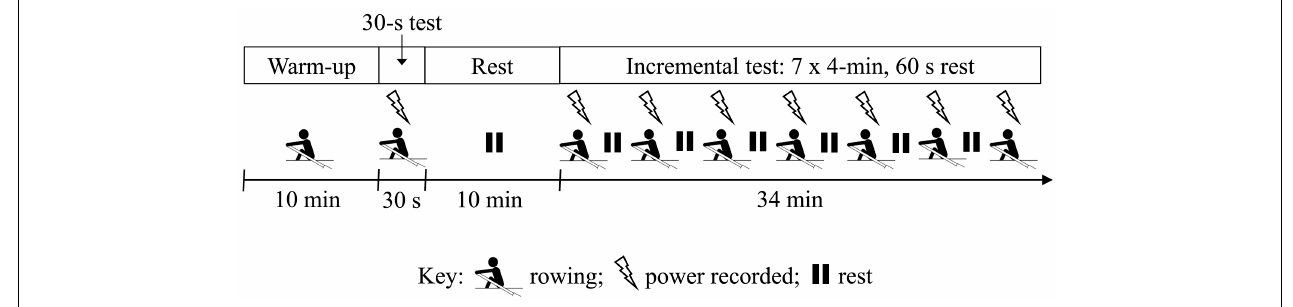
FIGURE 3 | Schematic of testing session protocol showing periods of rowing (rower icon), rest (pause icon), and when power was recorded from the five devices (lightning icon). Participants performed the same protocol in each of the five testing sessions, which were separated by 7 days.